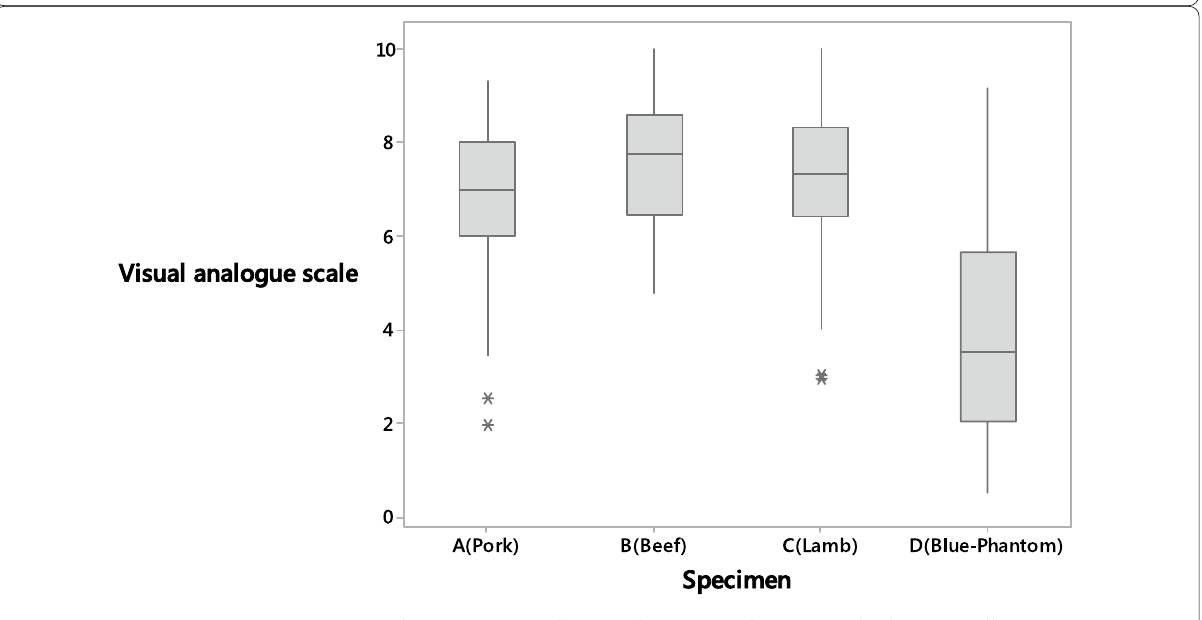
Fig. 4 Boxplot comparing the realism of the ‘feel’ of needling using a visual analogue scale (0 least like human tissue–10 most like human